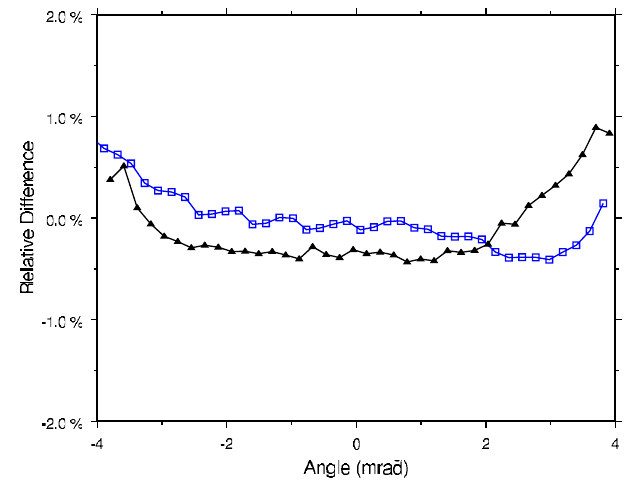
FIG. 10. (Color) Relative difference between measurement and theory in percent, open squares: 285 MeV SURF energy at 256.5 nm; and, filled triangles: 380 MeV SURF energy at 799.8 nm.